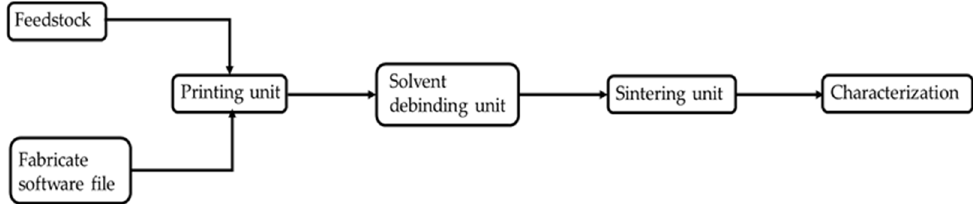
Figure 4. Manufacturing process diagram.